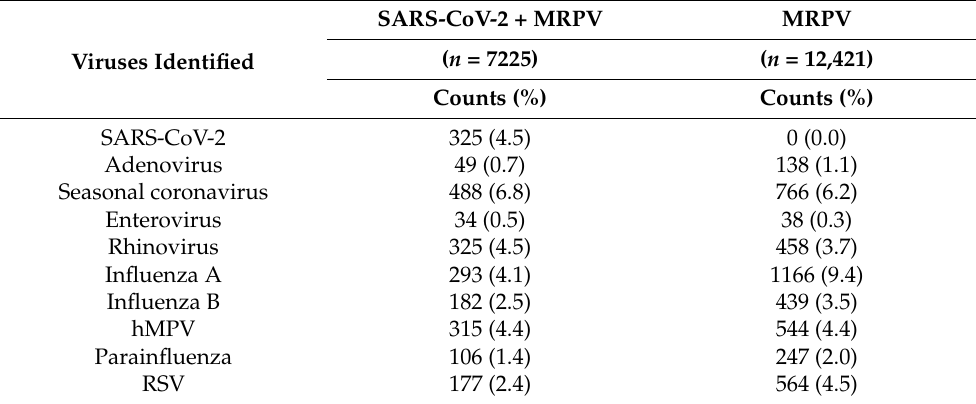
Table 2. Respiratory viruses identified in specimens tested for (i) SARS-CoV-2 + MRVP versus (ii) MRVP alone.